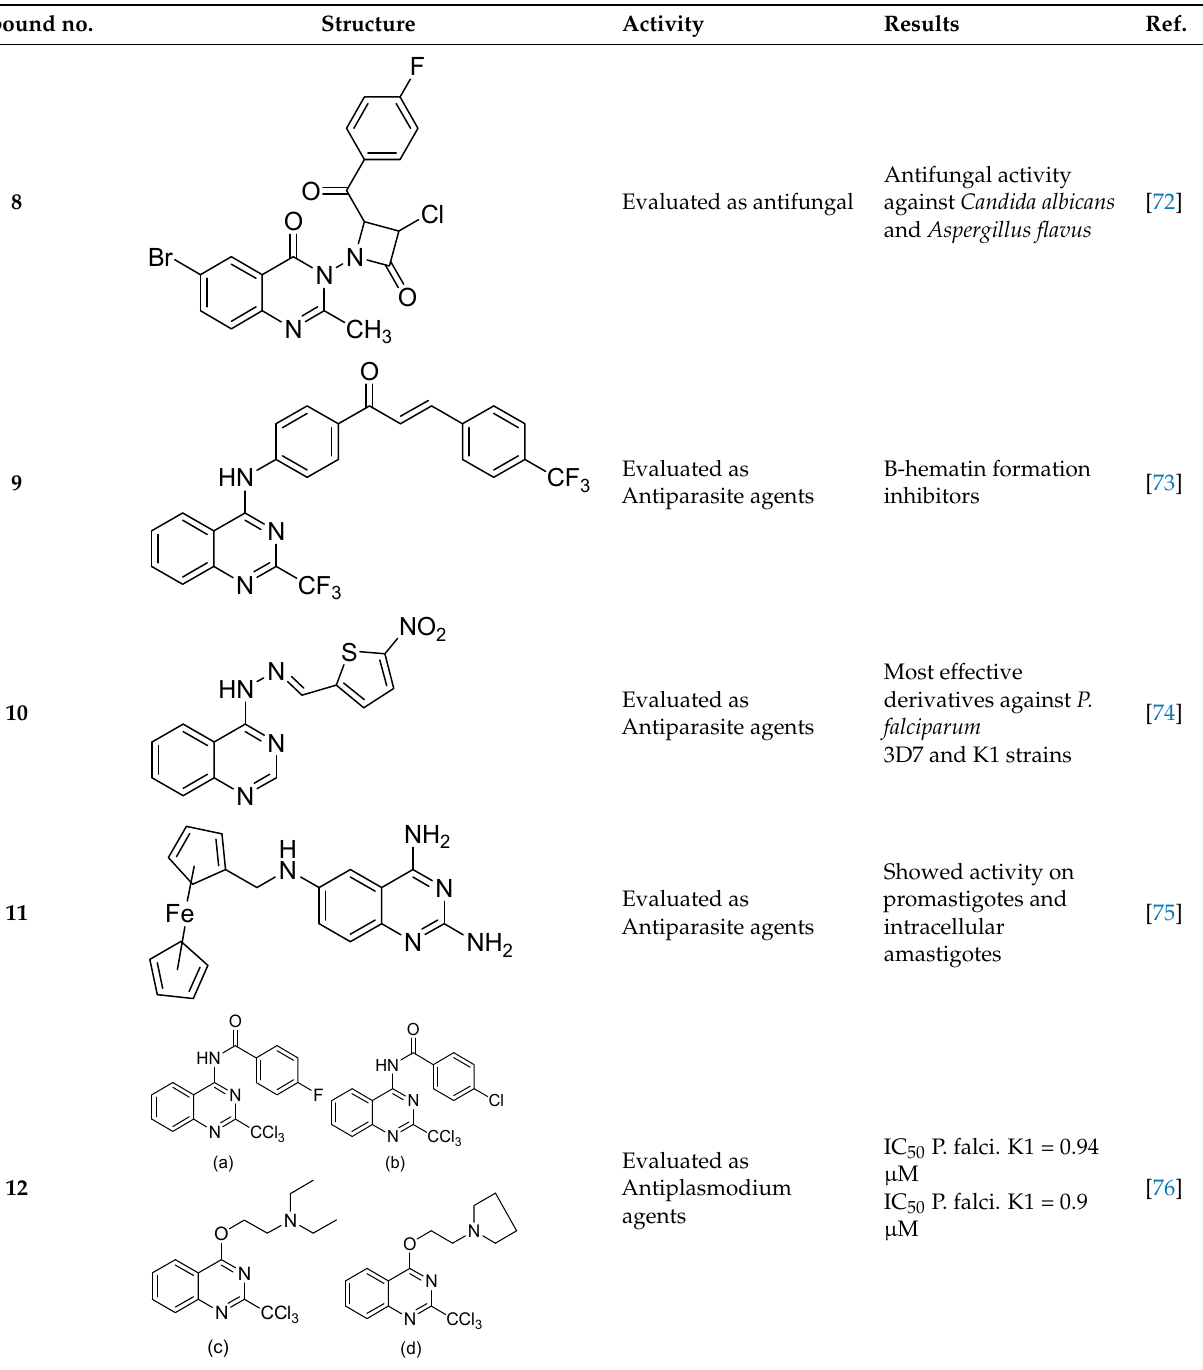
10. Quinazoline as Anti-Inflammatory Agents Stavytskyi et al. [66] synthesized substituted pyrrolo-quinazoline derivatives and tested their biological activity as an anti-inflammatory activity with reference to diclo- fenac. The synthesized compound as in Table 7, Compound 2, was found to be the most potent anti-inflammatory agent. Bansal et al. [67] designed and synthesized a novel class of 4-amino quinazoline derivatives and tested them for their anti-inflammatory activity.